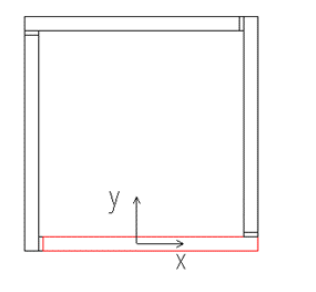
Fig. 7 X direction in the cross-section.